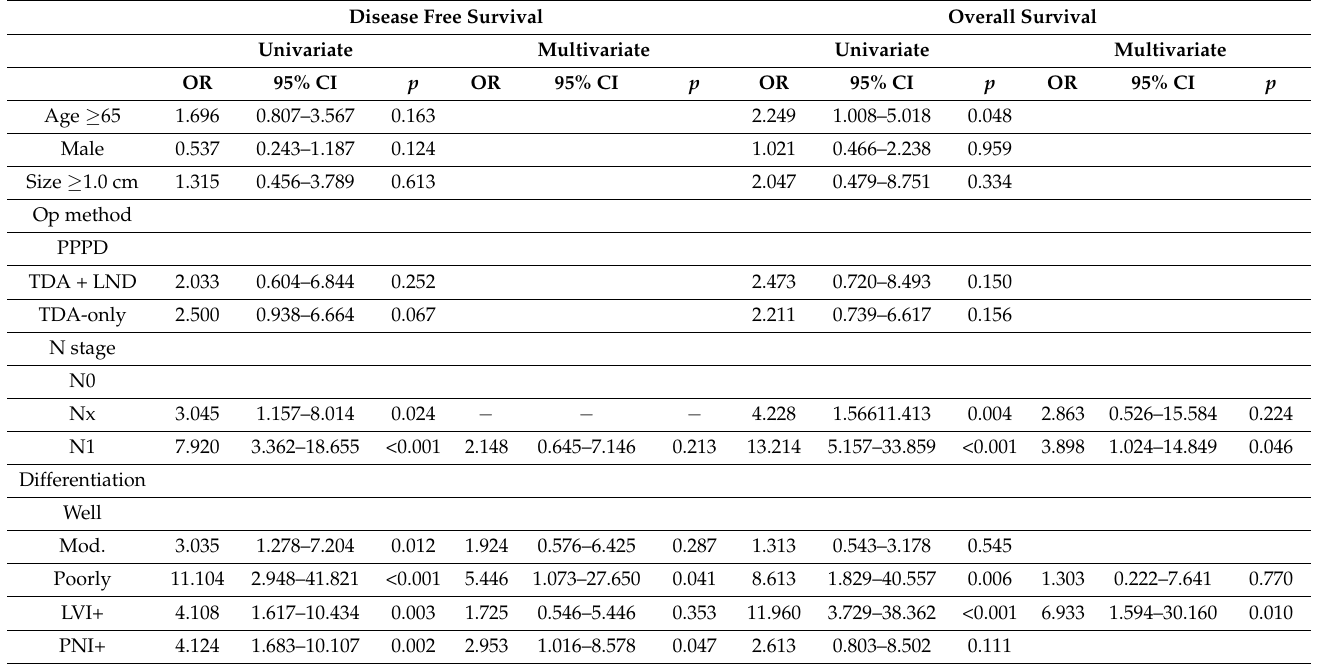
Table 4. Risk factor analysis for 5-year disease-free and overall survival in patients with T1 stage disease. Disease Free